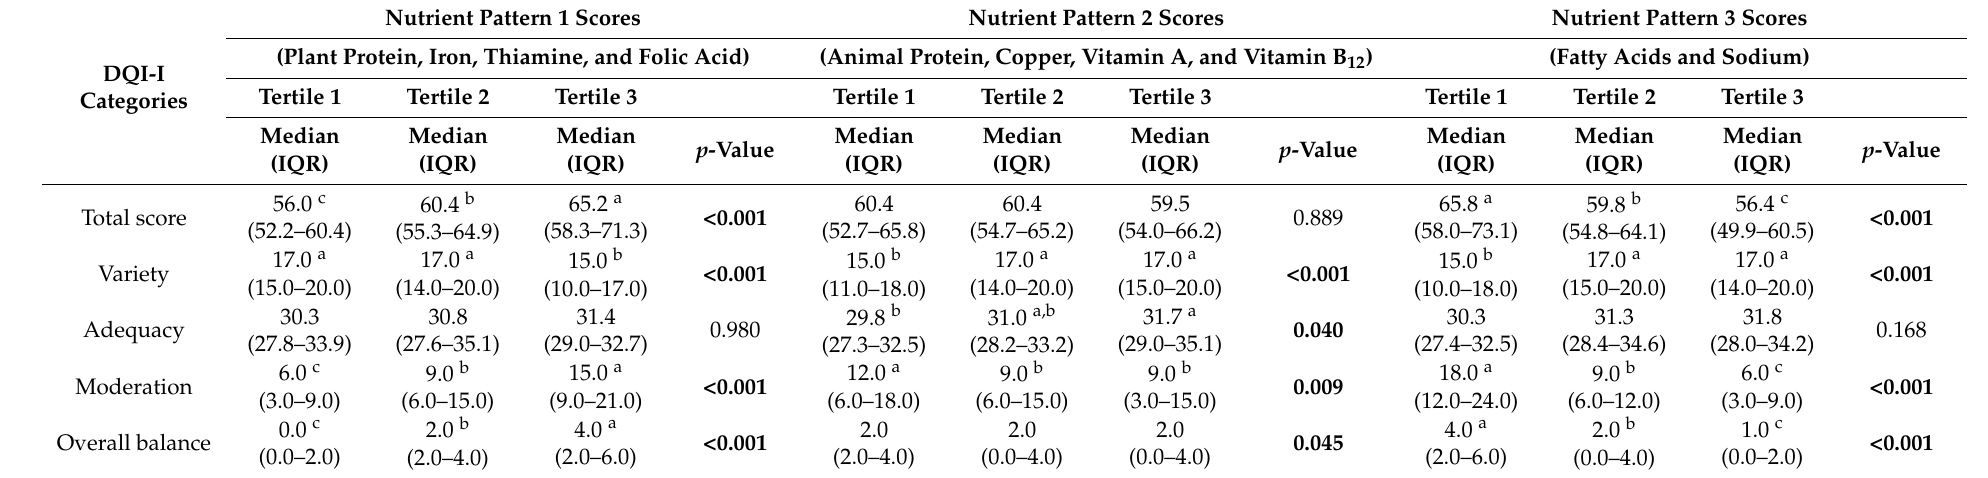
Table 5. DQI-I total and category scores by tertiles of nutrient pattern scores ( n =